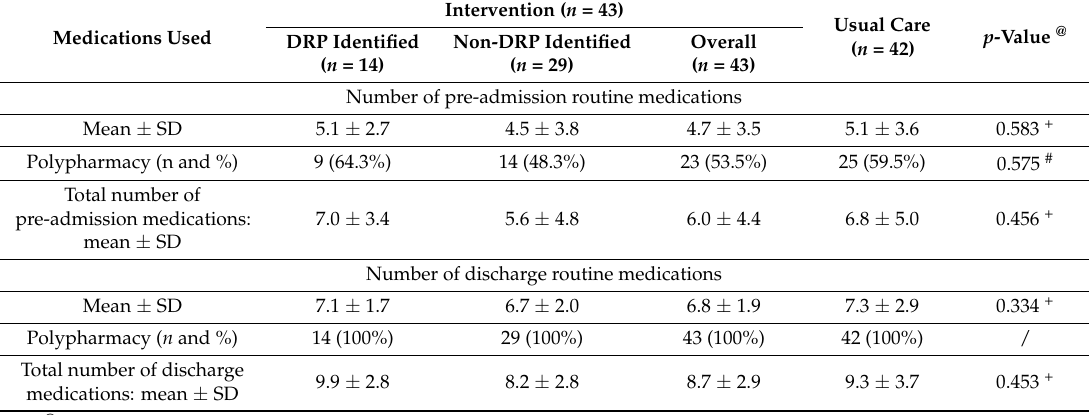
Table 2. Medication utilization statistics of study population.